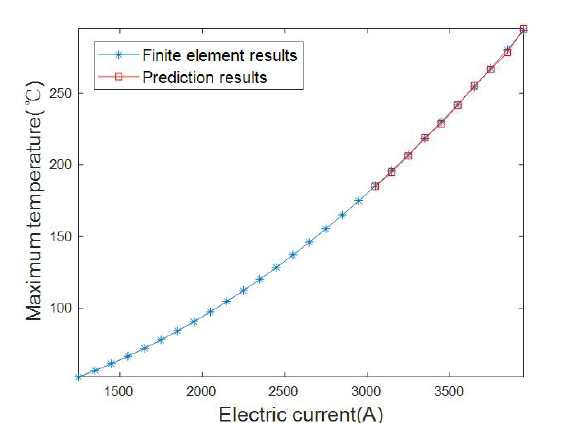
Fig. 13. Comparison of finite element calculation results and random forest prediction results